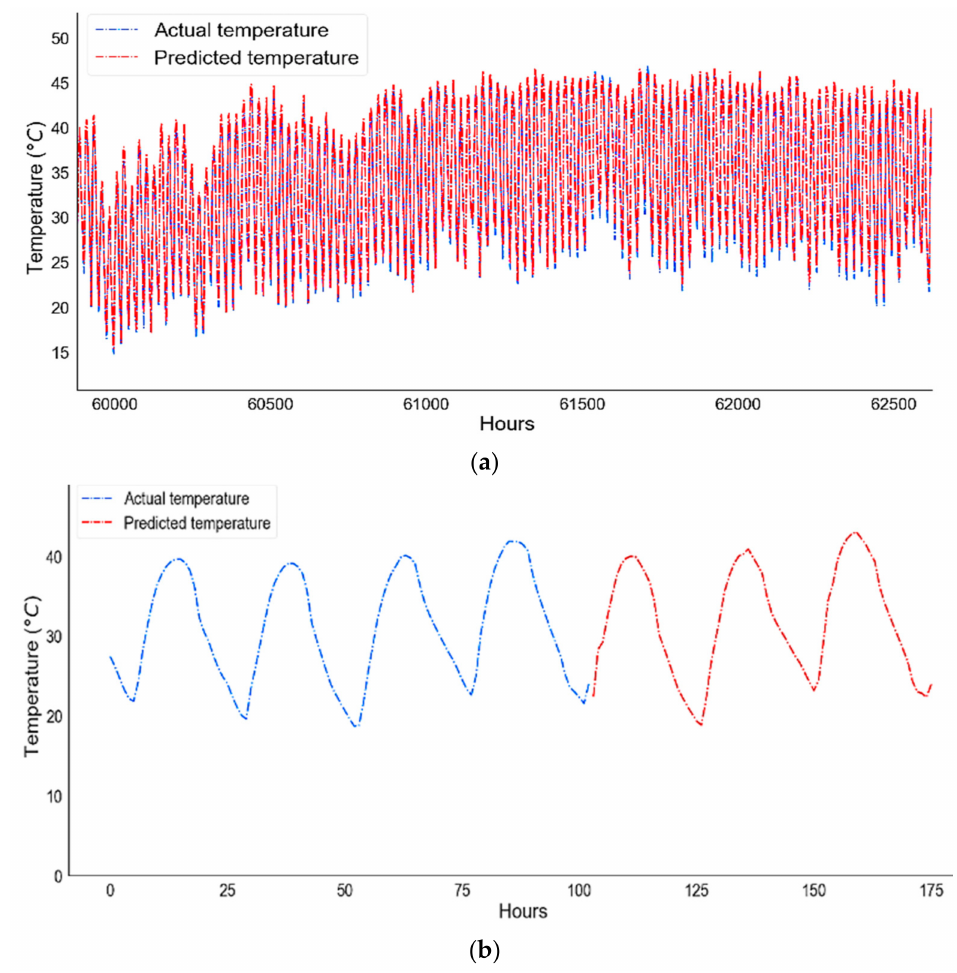
Figure 22. ( a ) The real and predicted values of temperature, which show the fit and performance of the BI-LSTM model; and ( b ) the temperature’s predicted future values for the next 169 h. Table 2. The forecasting accuracy indicators for the BI-LSTM